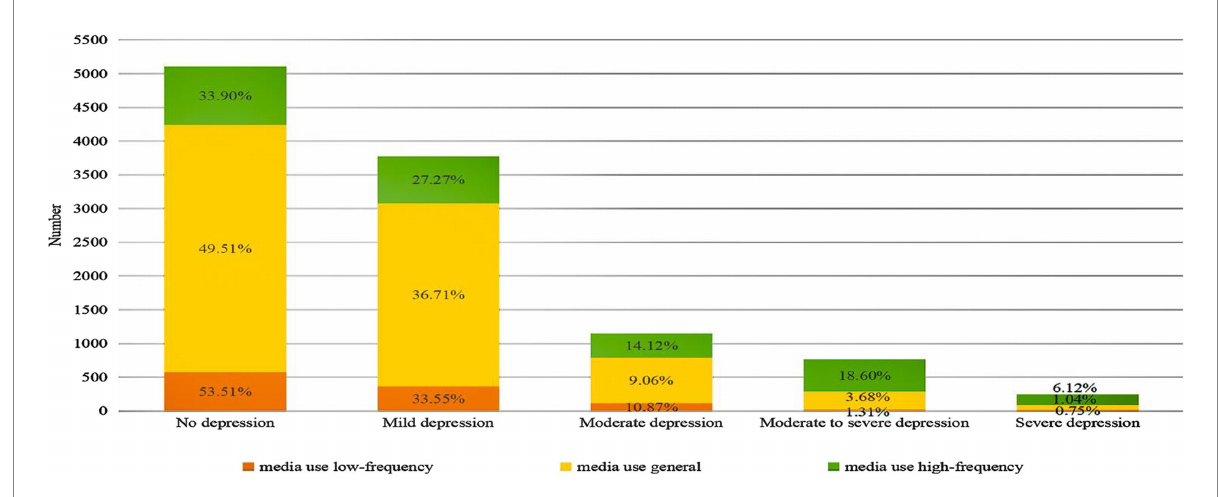
FIGURE 2 Number of residents concerned about depression and percentage of depression concern scores.